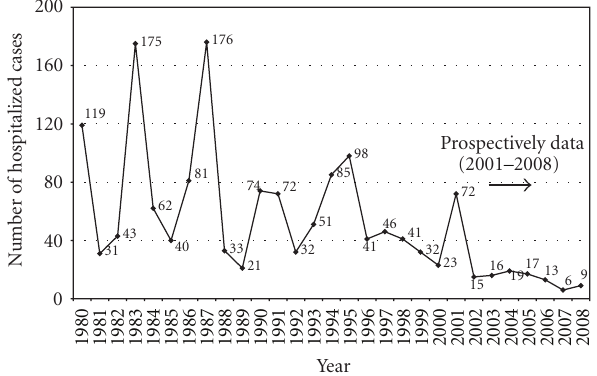
Figure 3: Age distribution of hospitalized Pertussis cases in the “Agia Sofia” Children’s Hospital by year